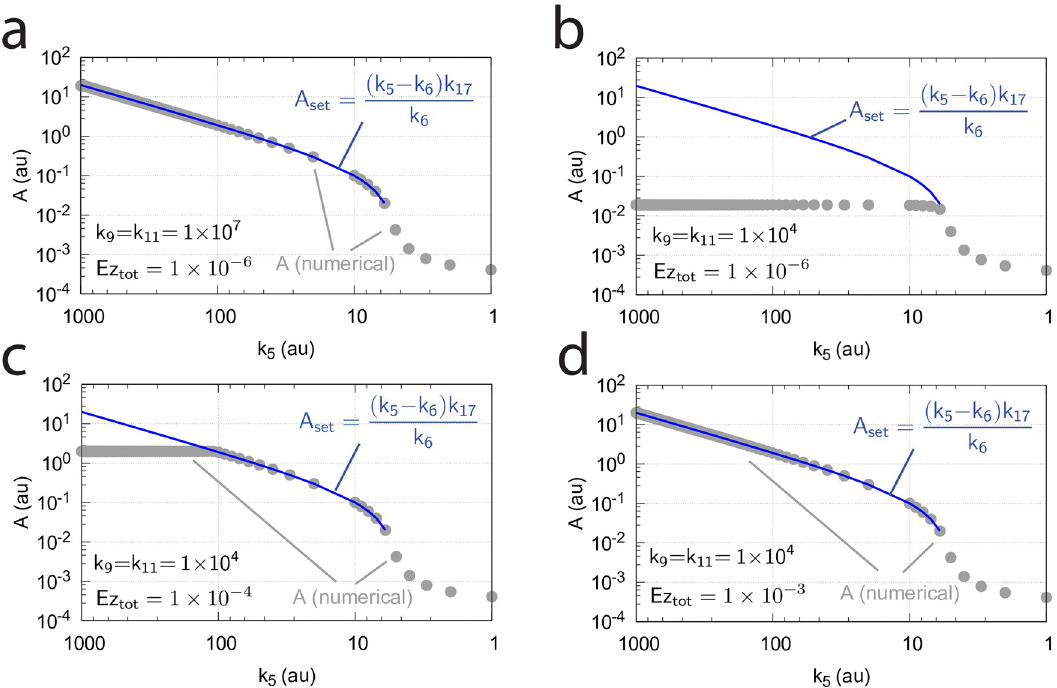
Fig 57. Influence of k 9 , k 11 , and Ez tot on the operational range of the controller from Fig 56a. (a) Optimum controller behavior for large k 9 and k 11 values (both 1 × 10 7 ) at Ez =1 × 10 − 6 . (b) Reducing k 9 and k 11 to 1 × 10 4 leads to a complete loss of the tot controller’s homeostatic behavior. Although the steady state values of A (gray circles) are independent and constant for k 5 > k 6 , they depend on the perturbation k 1 , which will be illustrated below for scheme Fig 56b. (c) Increasing the total enzyme concentration to 1 × 10 − 4 partially improves the controller’s performance. (d) Increasing the total Ez concentration to 1 × 10 − 3 restores the homeostatic behavior as the increased k 9 and k 11 values in (a) at low Ez . Other rate constants (a)-(d): k 1 =100, k 2 = k 3 =0, k 4 =10.0, tot k 6 =5.0, k 7 =1 × 10 8 , k 9 = k 11 = k 13 = k 15 =1 × 10 8 , k 10 = k 12 = k 14 = k 16 =1 × 10 3 , k 17 =0.1. Initial concentrations (a)-(d): A 0 =0.08,